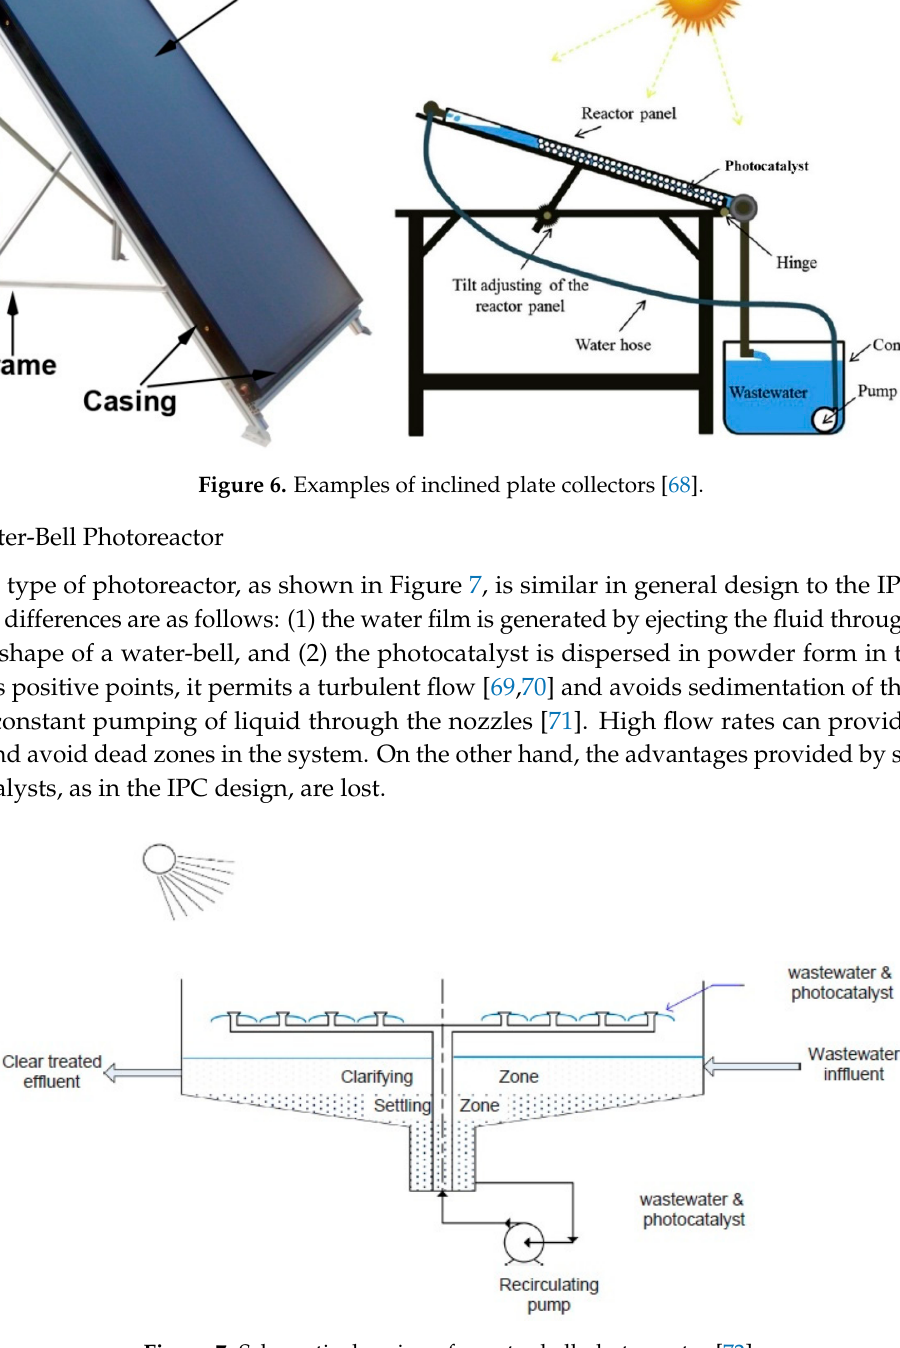
Figure 7. Schematic drawing of a water-bell photoreactor [72].